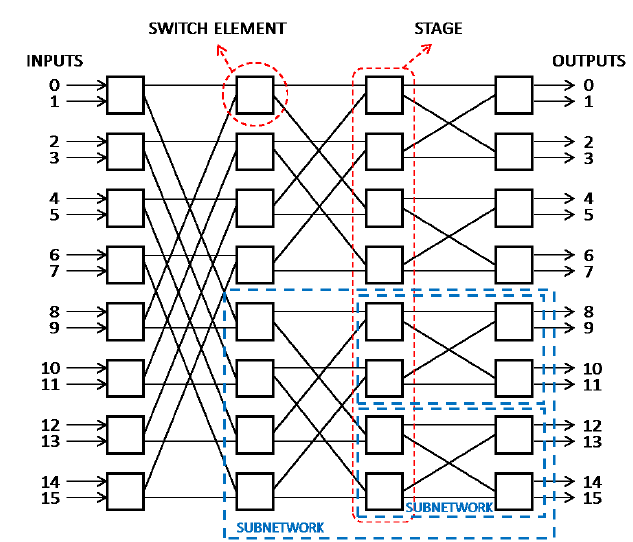
Figure 1. An N × N (with N = 16) Banyan multistage switching network (MSSN) featuring butterfly